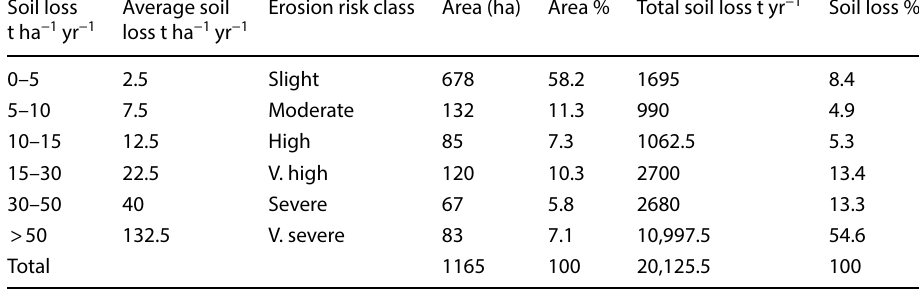
Fig. 6 Map of soil loss dis- tribution and sites of gully, suspended sediment, and sediment